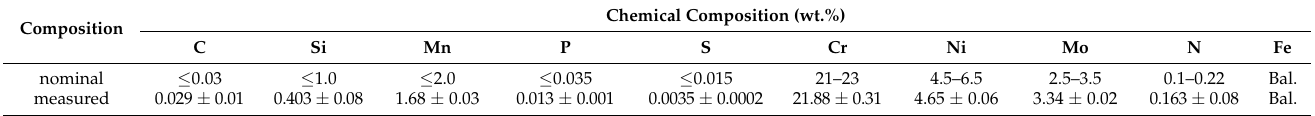
Table 1. Chemical composition of the DSS X2CrNiMoN22-5-3 determined by spark spectroscopy analyses (wt.%) and the nominal composition according to SAF 2205 ® AISI 318 LN. Chemical Composition